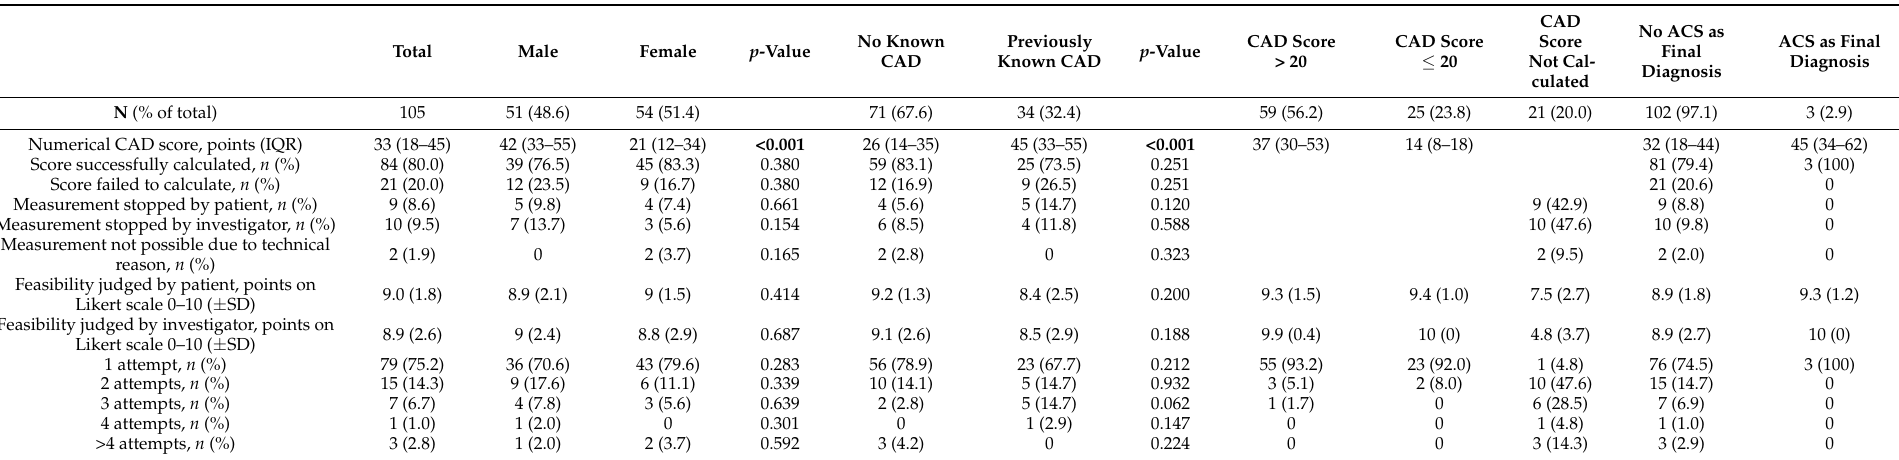
Table 2. Details of the CAD score measurement. Values are given for the total study cohort and subgroups concerning gender, known coronary artery disease (CAD), calculated CAD score, and final diagnosis regarding acute coronary syndrome (ACS). Categorical data are presented as counts and percentages, continuous data as means and standard deviations (SD) or medians and interquartile ranges (IQRs). Categorical data are analyzed using a test for linear association (Maentel–Haenszel chi-square test), continuous data using Kruskal–Wallis test for testing within the